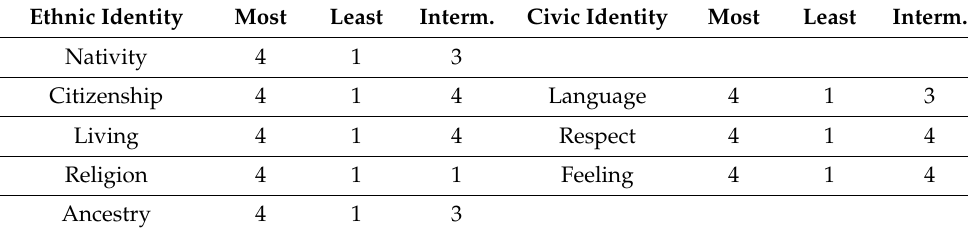
Table 4. Fuzzy cluster